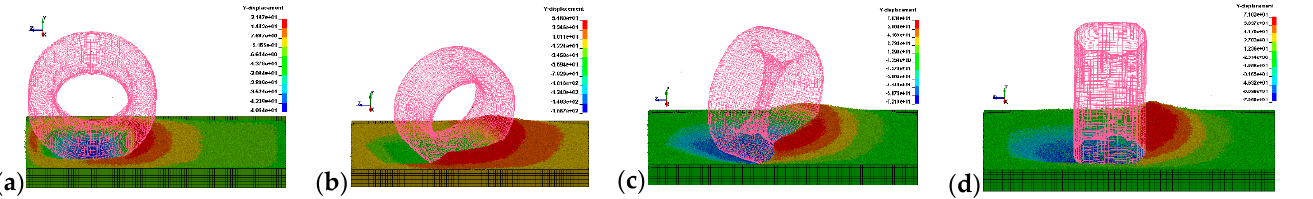
Figure 13. Map of the Y-axis DEM particles displacement counters as a result of the action of gravity for the following slip angles: ( a ) 0°, ( b ) 30°, ( c ) 60°, and ( d ) 90°.